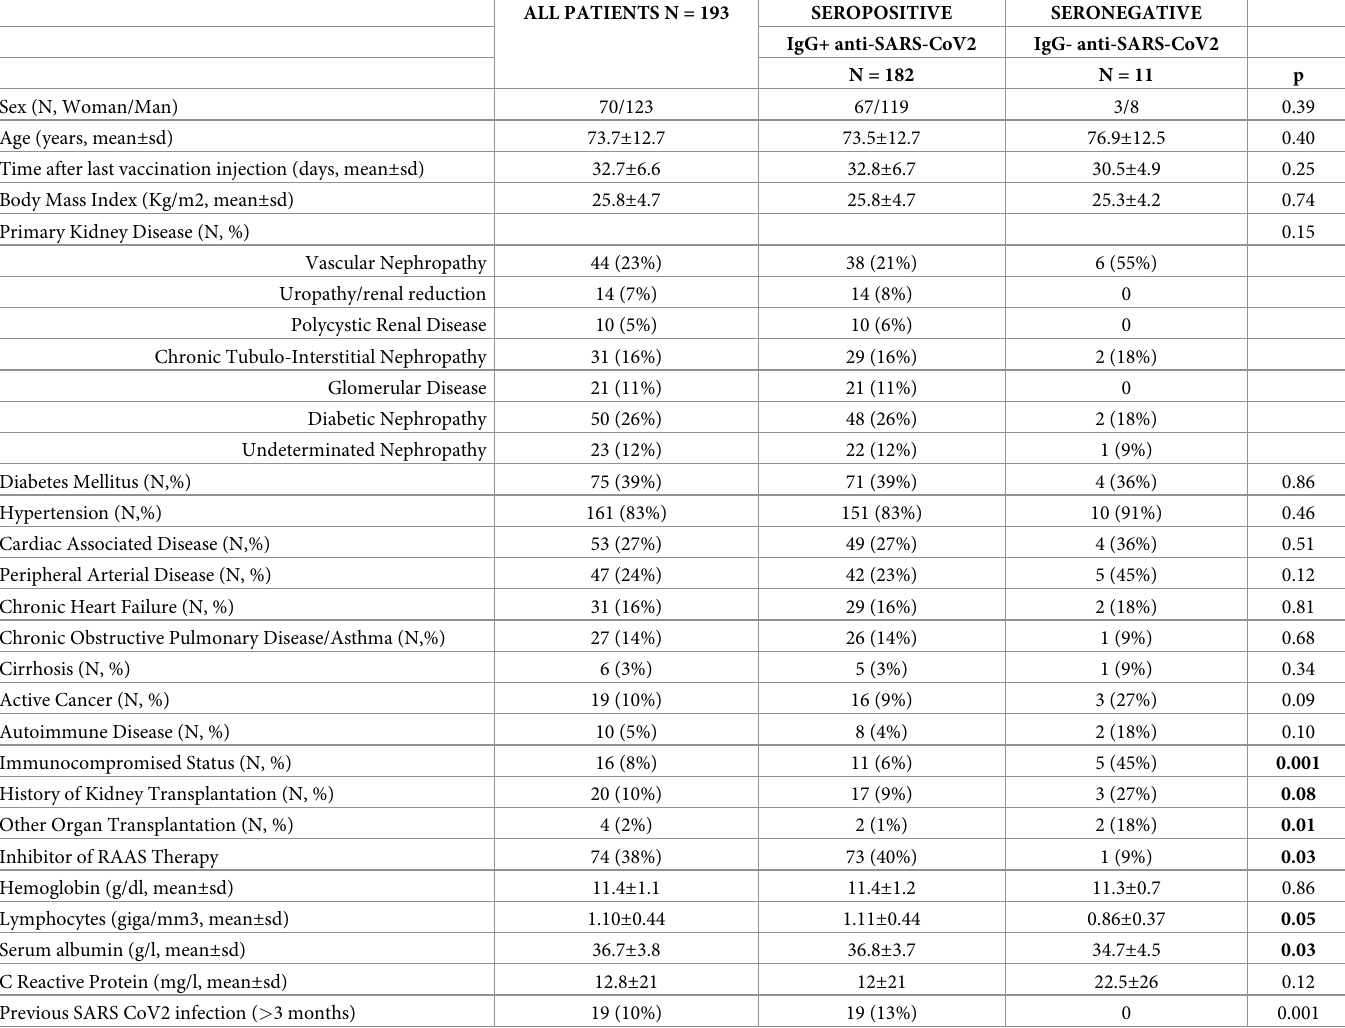
Table 1. Baseline characteristics according to IgG anti SARS-CoV2 response �